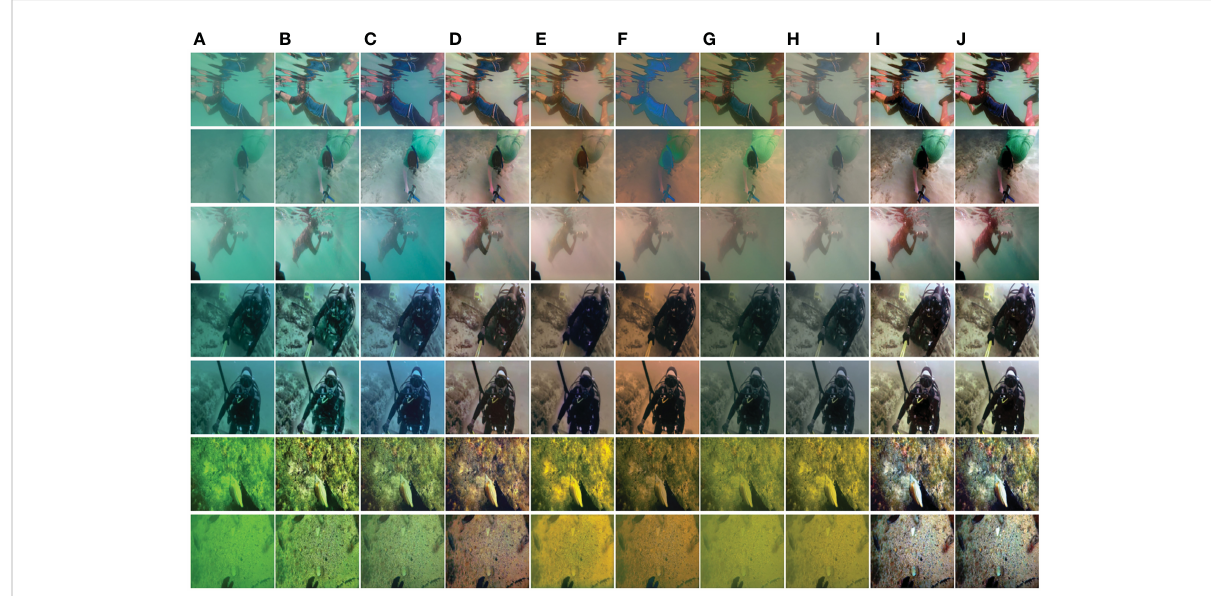
FIGURE 8 Visual comparisons on the EUVP dataset. From left to right, (A) shows the raw underwater images, (B – J) are the results of CLAHE (Pizer et al., 1990), OMGD (Ren et al., 2021), UGAN-P (Fabbri et al., 2018), FUnIE-GAN (Islam et al., 2020), WaterNet (Li et al., 2019), UWCNN (Li et al., 2020), Shallow-UWnet (Naik et al., 2021), Spiral-GAN (Han et al., 2020) and the proposed model,